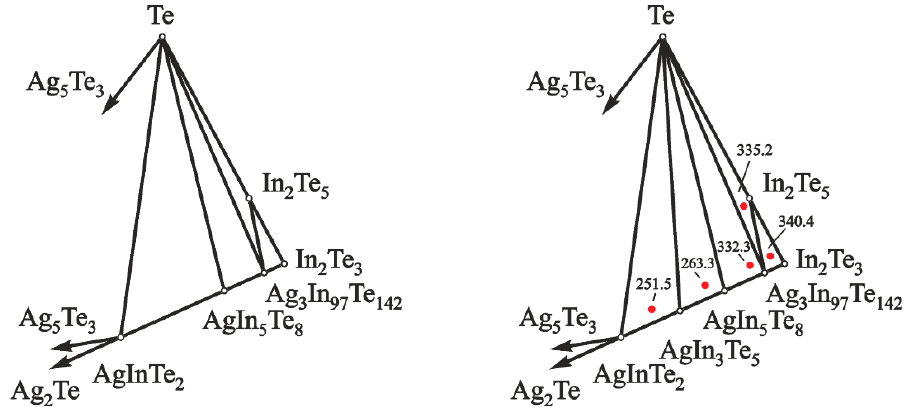
Figure 2. Division of the concentration space in the Ag–In–Te system, in the part AgInTe 2 –Te–In 2 Te 3 , below 500 K, according to data of [18–20] ( left ) and the present study ( right ). Red dots indicate EMF values (mV) of the GCs and compositions of the positive electrodes at 460 K.